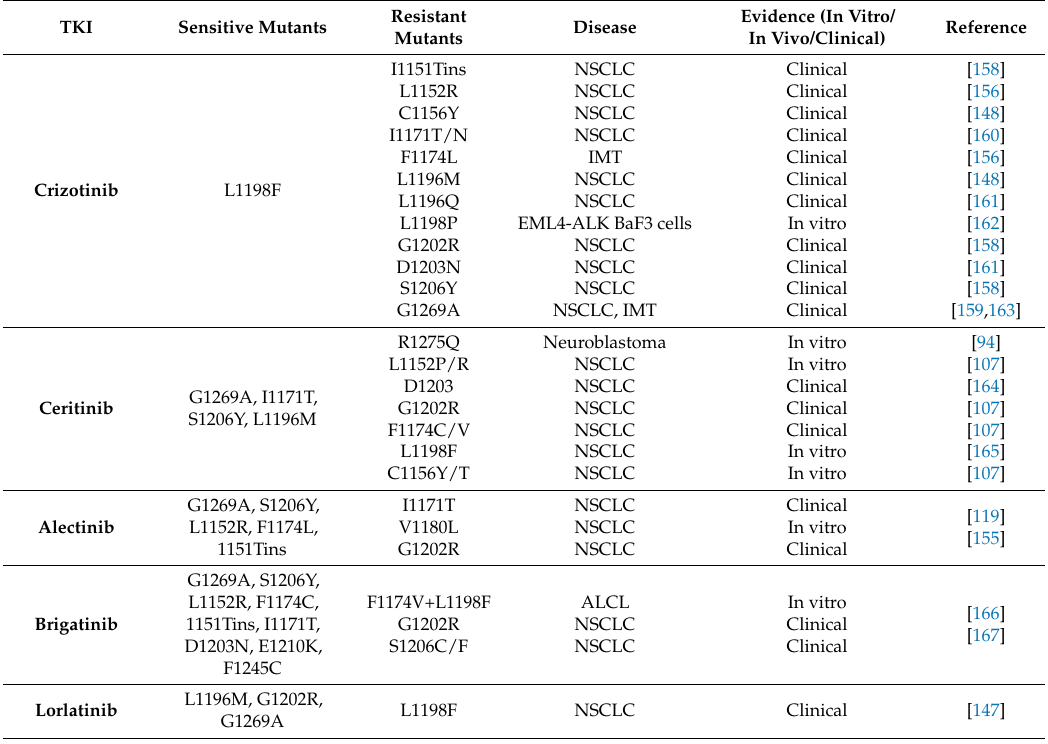
Table 3. Mutational profile of ALK that induce TKI